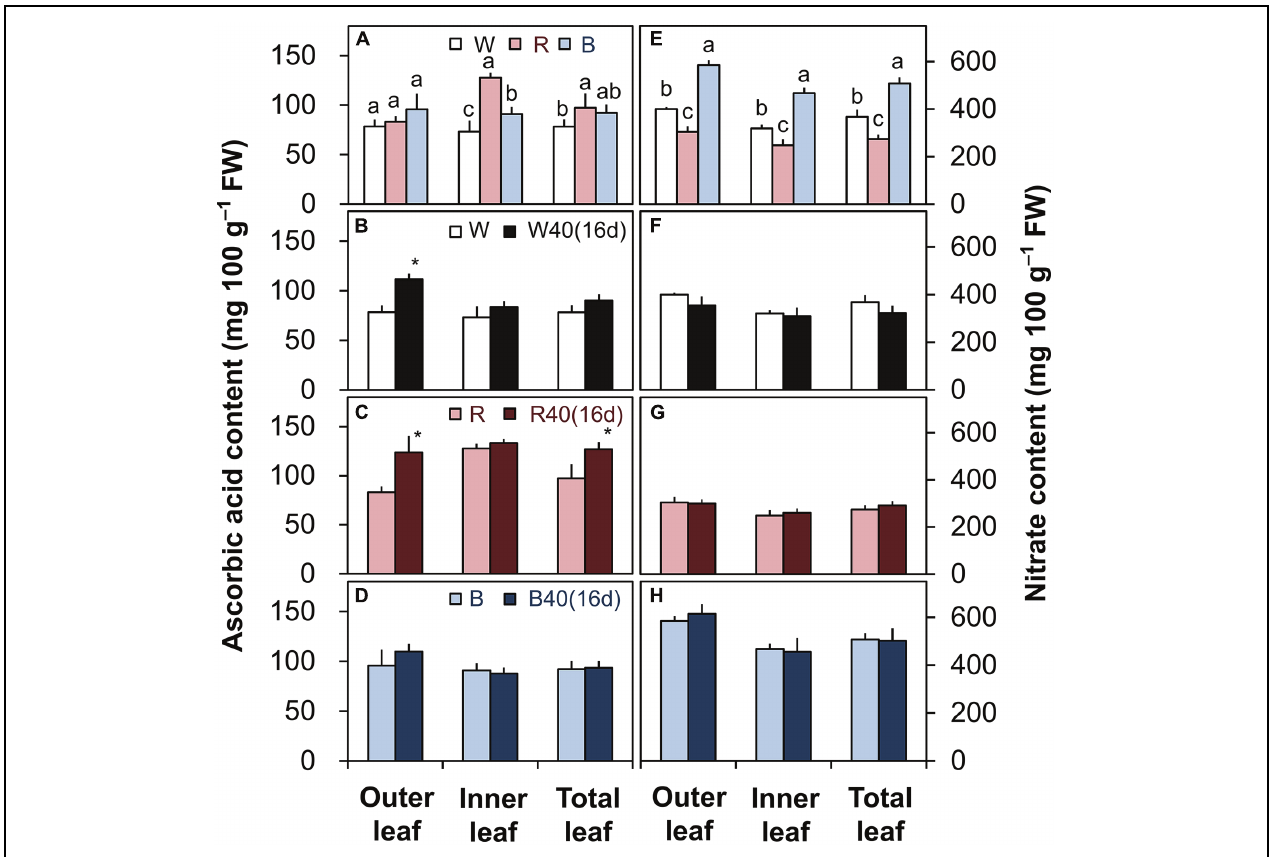
FIGURE 6 | Ascorbic acid (A–D) and nitrate contents (E–H) in the outer leaves, inner leaves, and total leaves of lettuce plants grown under downward lighting by white (W), red (R), or blue (B) LEDs: (A,E) without or (B–D,F–H) with supplemental upward lighting at 40 µ mol m − 2 s − 1 PPFD for 16 days (“16d”). Data represent means ± SD ( n = 3 to 5). (A,E) Bars labeled with different letters differ significantly among the same plant parts (Tukey’s HSD test, P < 0.05). (B–D,F–H) Bars labeled with “ ∗ ” differ significantly between treatments (Student’s t -test, P <